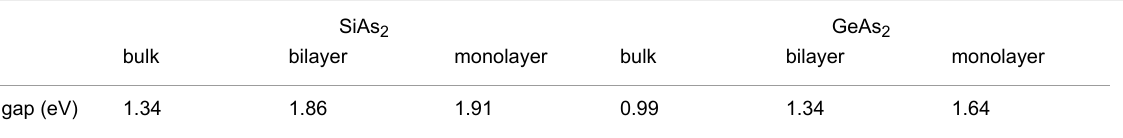
Table 2: Calculated band gaps of SiAs 2 and GeAs 2 for bulk, bilayers and monolayers.